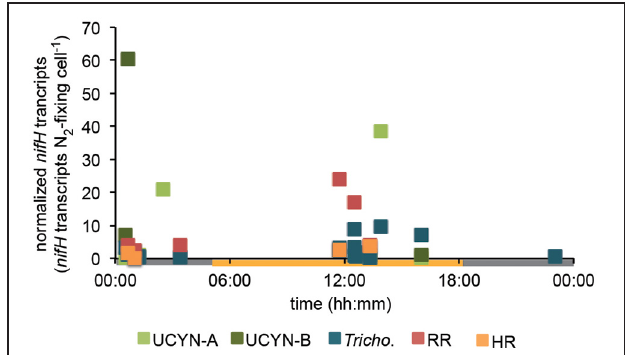
FIGURE 3 | Diel nifH expression normalized to the abundance of each phylotype. Expression data across all stations was pooled, and transcript numbers were normalized to each N 2 -fixing cell using nifH -based abundances at each station reported in Goebel et al. (2010), and assumptions outlined in the methods section. DNQs for DNA and RNA were changed to 100 and 250 nifH copies/transcripts L − 1 for these calculations,